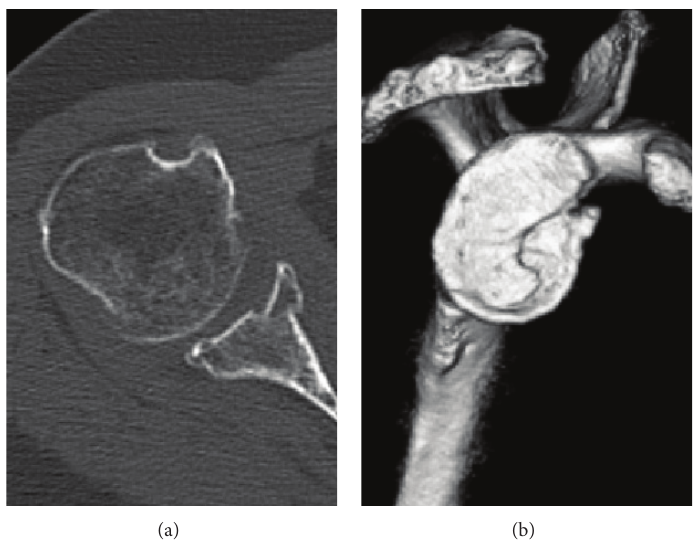
Figure 2: CT imaging upon initial presentation at our hospital. (a) Axial CT imaging showing a large glenoid rim fracture and an articular step-off of 2.5 mm. (b) The width of the bony fragment was 30% of the glenoid length on the three-dimensional